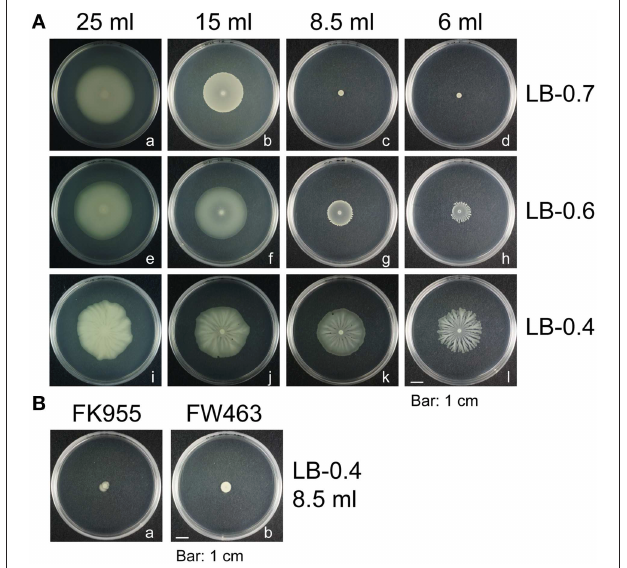
FIGURE 1 | Morphology of B. subtilis colonies. (A) B. subtilis F29-3 was cultured on plates containing 6–25ml LB medium containing 0.4% (LB-0.4), 0.6% (LB-0.6), or 0.7% (LB-0.7) agar. (B) FK955 (a surfactin-synthesis mutant of F29-3) (a) , and FW463 (a flagellar mutant of strain F29-3) (b) were cultured